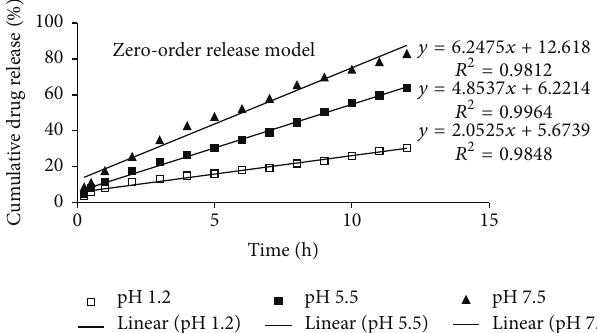
Figure 15: % Cumulative pheniramine maleate release versus time (zero-order release) from EGDMA cross-linked AA/Gelatin hydrogels.